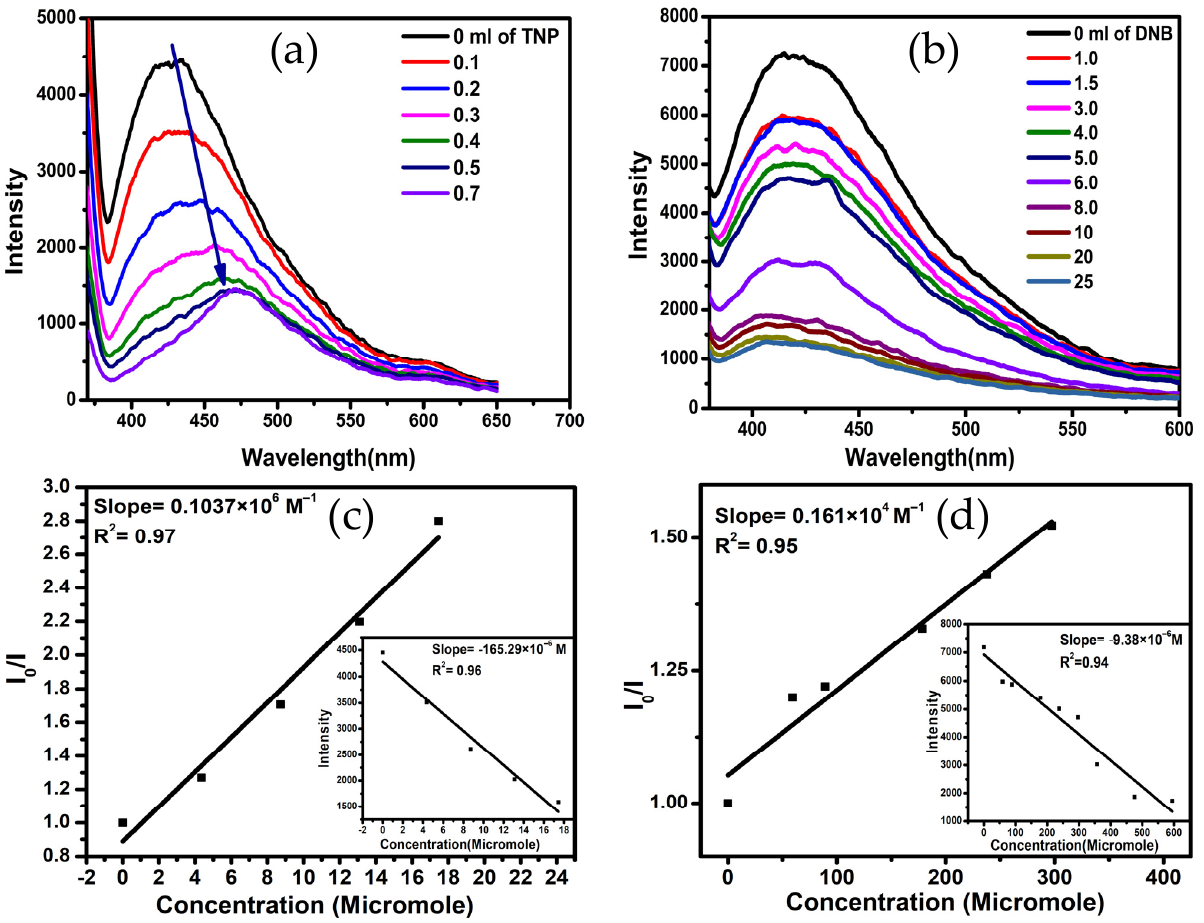
Figure 10. ( a ) Fluorescence spectra of the PANI-Ag composite with TNP. ( b ) Fluorescence spectra of the PANI-Ag composite with DNB. ( c ) Stern–Volmer plot inserted with LOD plot of the PANI- Ag composite with TNP. ( d ) Stern–Volmer plot inserted with LOD plot of the PANI-Ag composite with DNB.